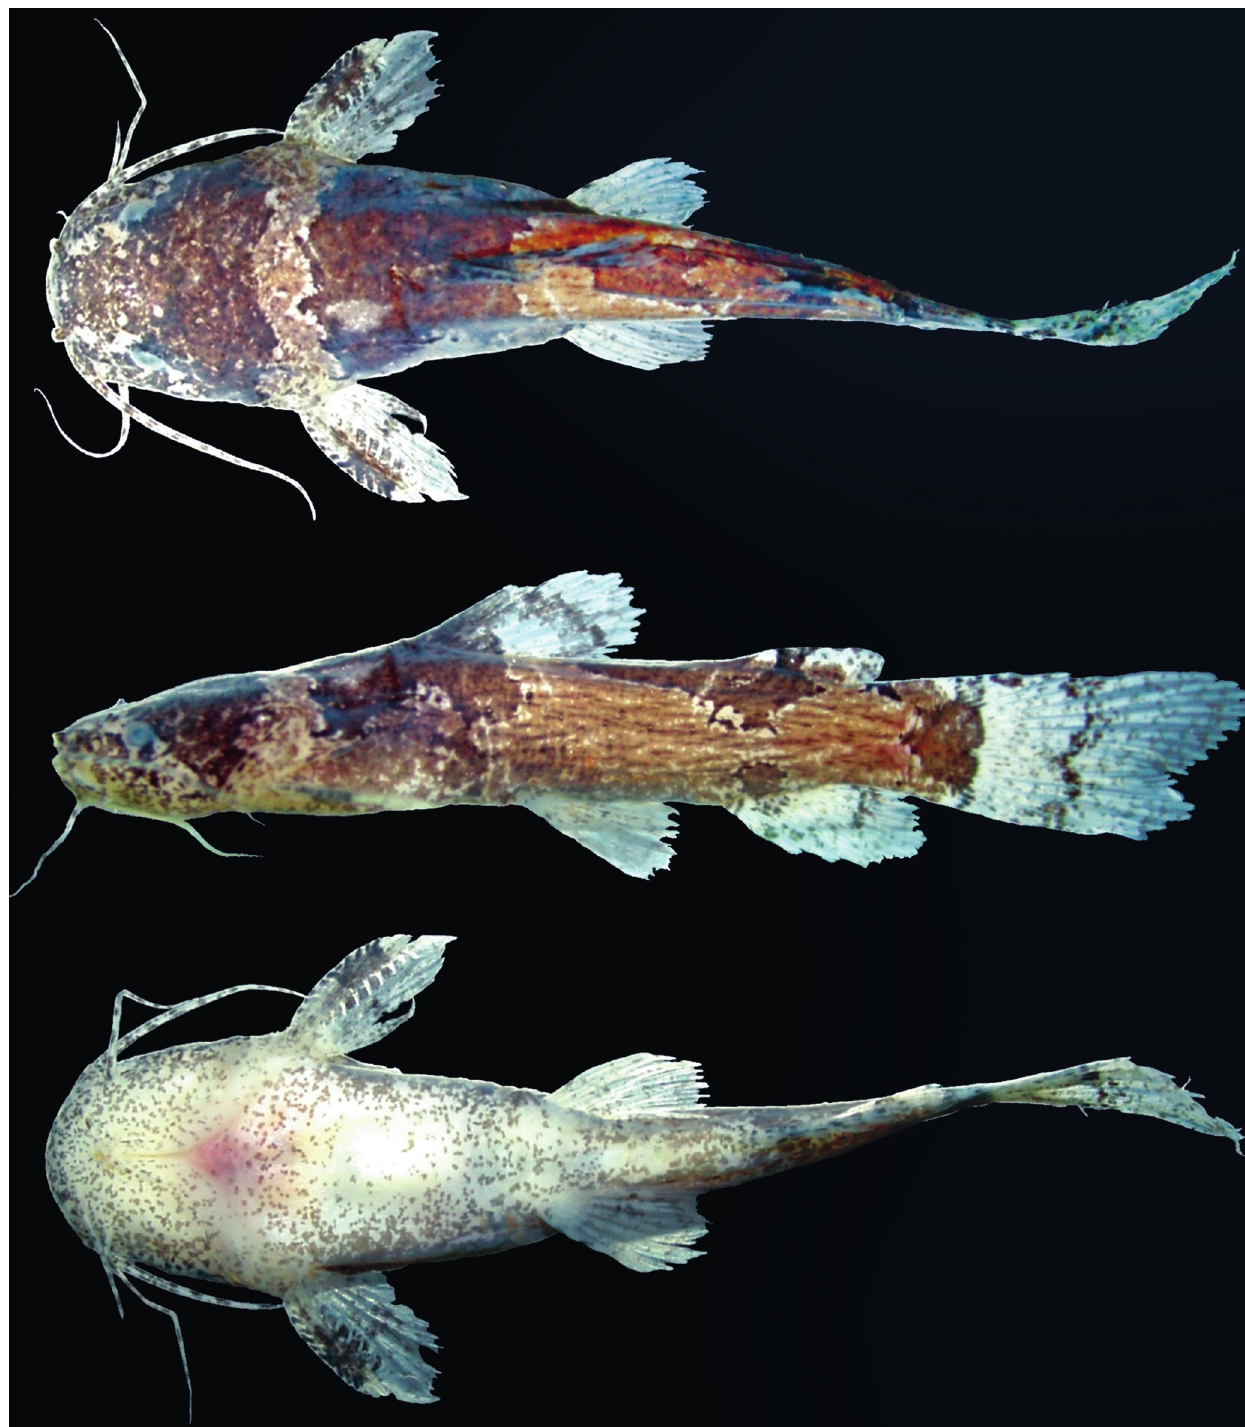
Fig. 1. Microglanis oliveirai , holotype, INPA 35623, 26.3 mm SL, rio Corrente, rio das Mortes basin, Mato Grosso State, Brazil. Dorsal, lateral and ventral